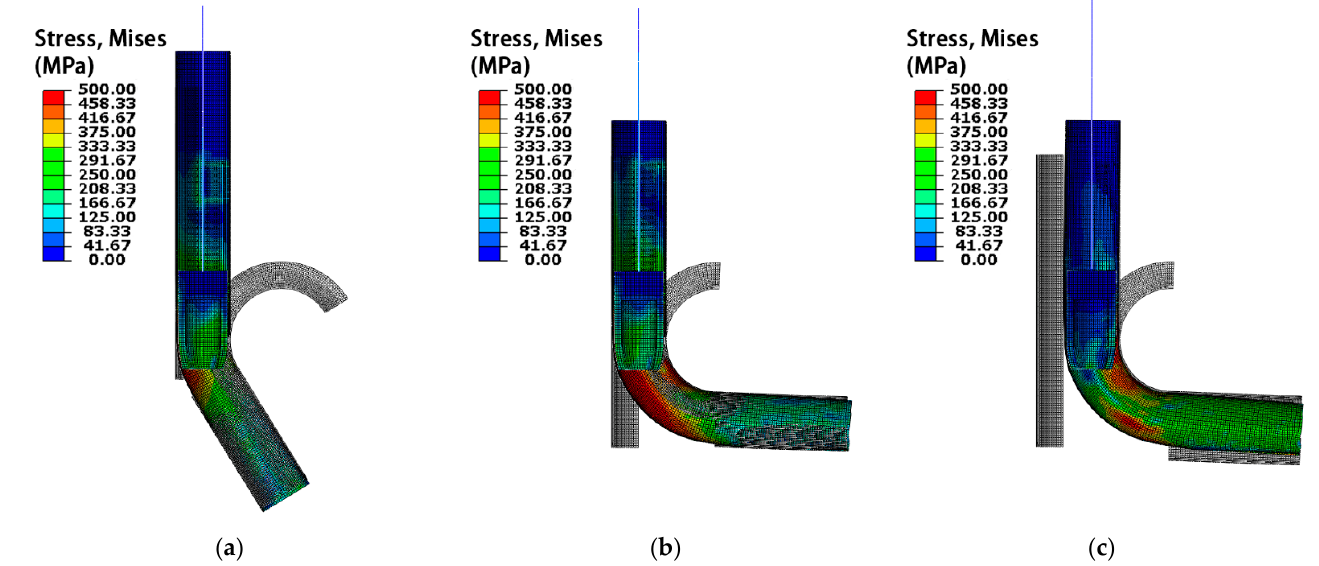
Figure 8. Stress distribution of hollow mandrel scheme 1: ( a ) bending step; ( b ) end of bending step; ( c ) unloading step.